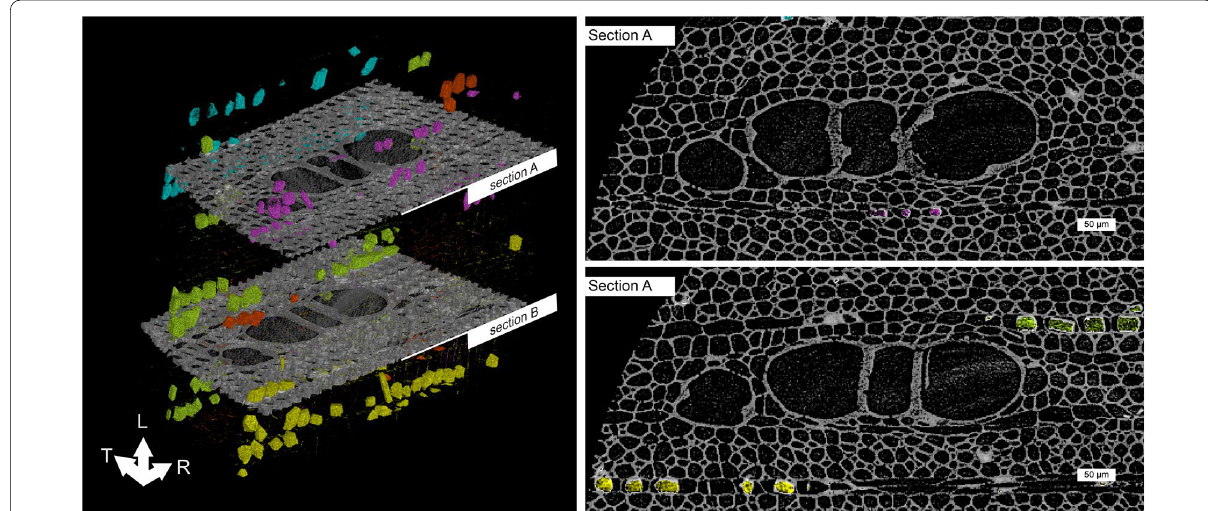
Fig. 5 Spatial arrangement of the prismatic crystals surrounding the vessels in sheath 4. Left: 3D visualization of the wood by isolating the prismatic crystals (blue, green, red, purple, and yellow particles) and two consecutive transverse sections (sections A and B). The different colors of the particles show different tangential positions of the crystals. Right: 2D views of sections A and B. L longitudinal direction, R radial direction, T tangential